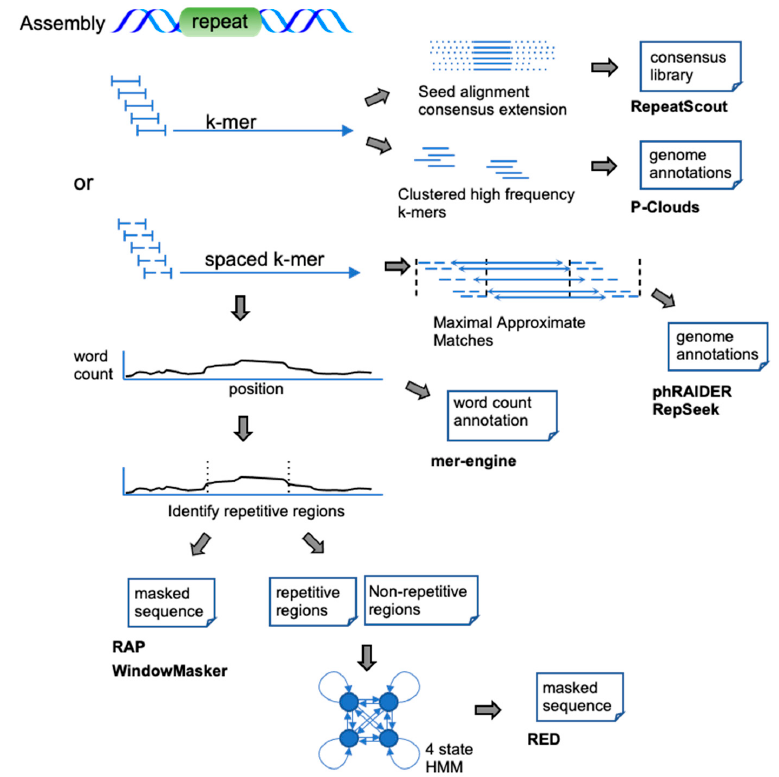
Figure 2. K-mer-based approaches on sequence assemblies. Upon characterizing the k-mer composition of the assembly, the word counts are either: simply used to annotate each base of the sequence (mer-engine), used to discriminate regions of high repetitiveness (RAP, WindowMasker, RED), clustered (P-Clouds), or used as anchors in a seed and extension process (RepeatScout, phRAIDER, RepSeek).